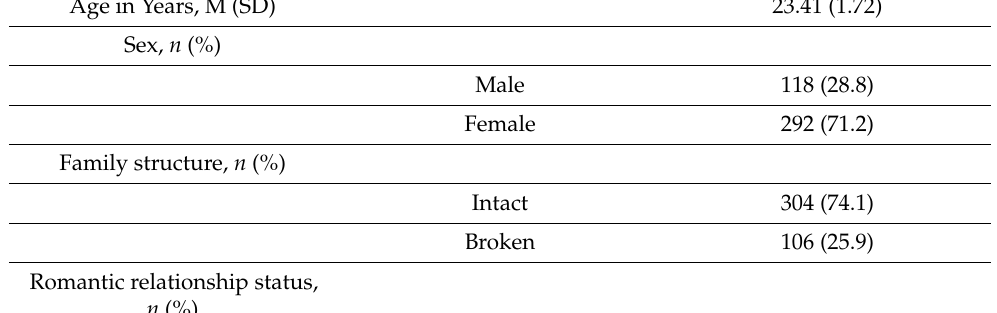
Table 1. Sample Demographic